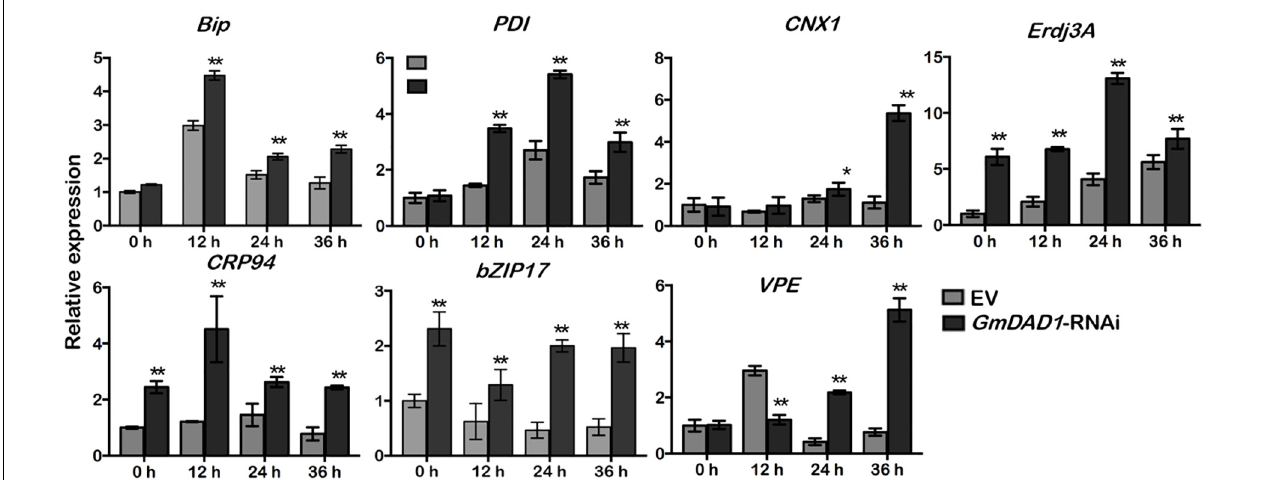
FIGURE 6 | GmDAD1 is involved in P. sojae -activated ER stress signaling. Expression patterns of ER stress-related genes in the EV and GmDAD1 -RNAi transgenic hairy roots after inoculation with P. sojae at 0, 12, 24, 36 hpi. Values represent the means of three replicates ± SD. Data were analyzed by using Student’s t -tests ( ∗ P < 0.05, ∗∗ P < 0.01 compared with the control).